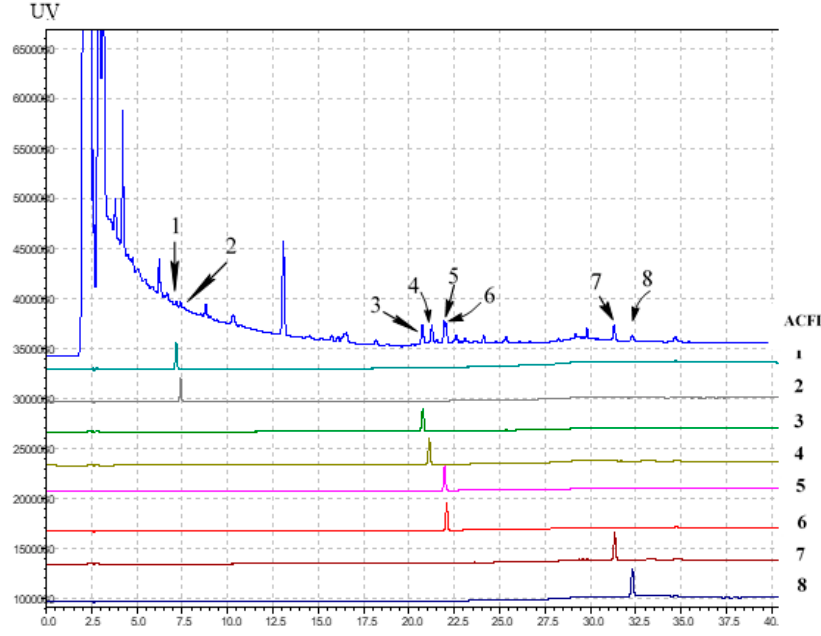
Figure 3. Identification of active inhibitors on the HPLC fingerprints of ACFB extract. 25 S -antcin K ( 1 ), 25 R -antcin K ( 2 ), dehydrosulphurenic acid ( 3 ), 25 S -antcin I ( 4 ), 25 S -antcin B ( 5 ), 25 R -antcin B ( 6 ), dehydroeburicoic acid ( 7 ) and eburicoic acid ( 8 ). Analysis conditions: The mobile phase consisted of water containing 0.1% phosphoric acid and acetonitrile (ACN) using a gradient program of 40–50% ACN from 0 − 12 min, 50 − 60% ACN from 12 − 17 min, 60 − 95% ACN from 17 − 26 min and 95 − 100% ACN from 26 − 50 min; separation column (Cosmosil 5C 18 -AR-II, 5 µ m, 250 × 4.6 mm i.d.) was employed, eluting at a flow rate of 1.0 mL/min at 35 ◦ C; the real-time UV absorption was detected at 210